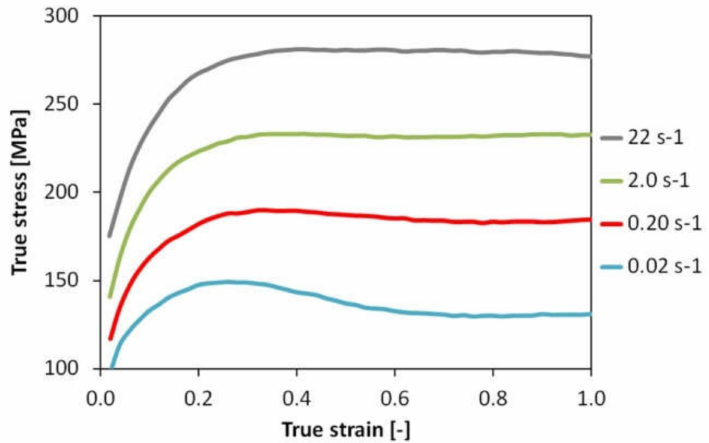
Figure 13. Influence of strain rate on flow curves at a nominal temperature of 840 ◦